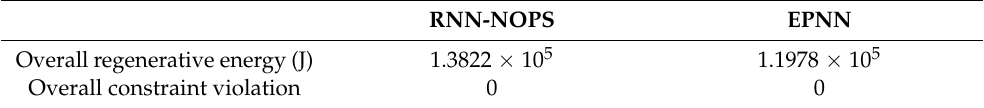
Table 4. Results of algorithms under SC03 in terms of regenerative energy and constraint violation.